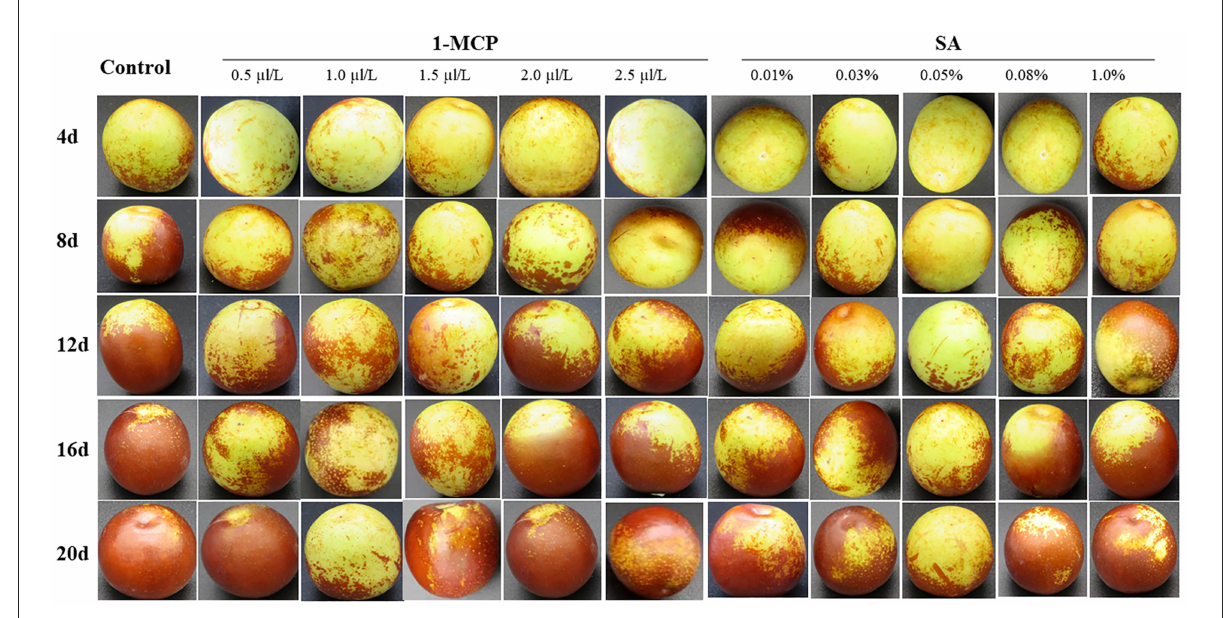
FIGURE1 Changes in cuticle color in winter jujube fruit treated with different concentrations of 1-methylcyclopropene (1-MCP) (0–2.5 µ l/L) and salicylic acid (SA) (0–1.0%) during shelf life at 4 ± 1 ◦ C for 20